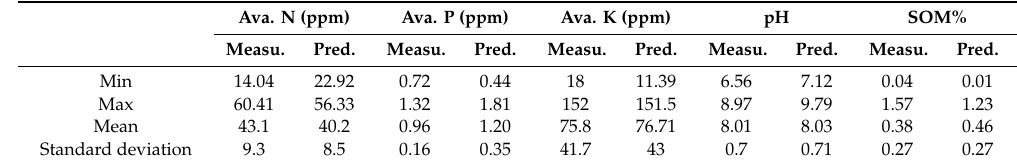
Table 5. Measured and predicted values of N, P, K, pH, and SOM.